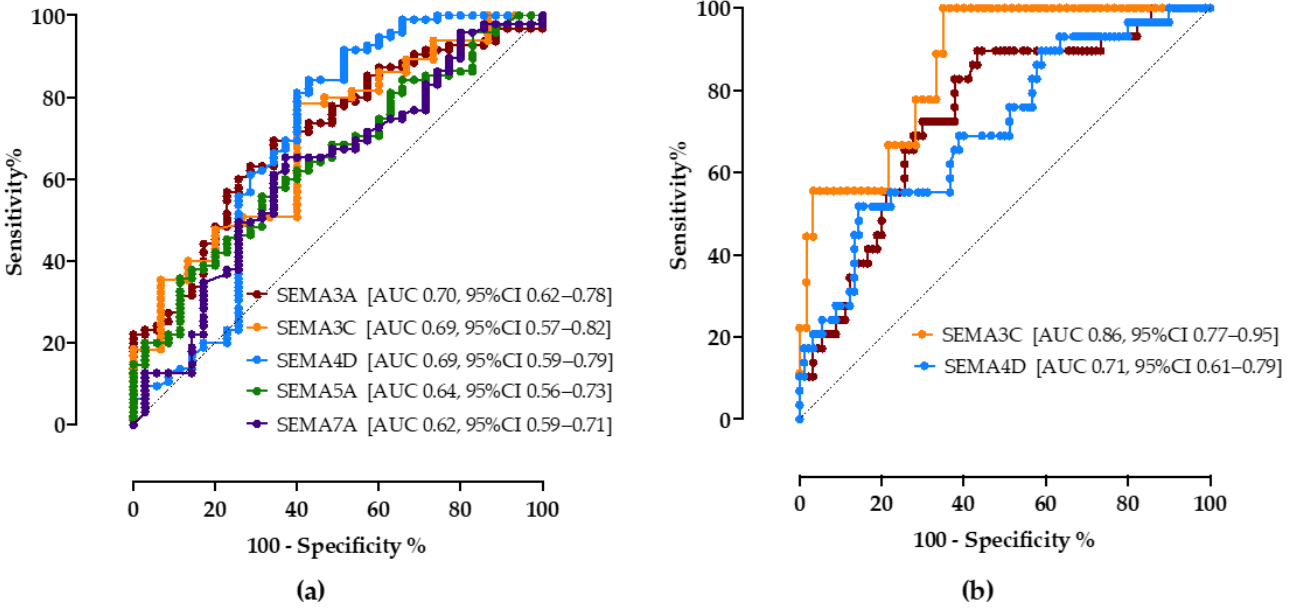
Figure 3. The ROC curve analysis of serum semaphorin concentrations for discrimination of NAFLD ( a ) and progressed fibrosis ( b ). Shown are AUC, area under the curve, with corresponding 95% confidence intervals.